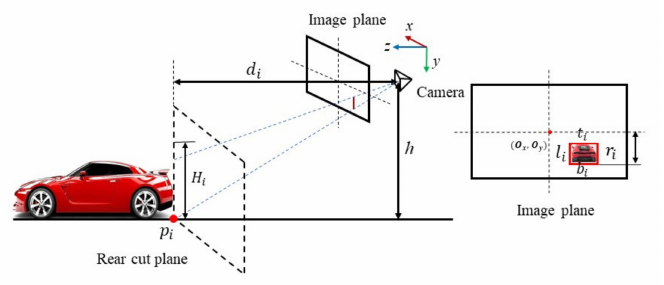
Figure 1. Perspective projection of the vehicle. In the above picture, p is the vehicle’s pickup point, d i denotes the distance to the previous vehicle, h denotes the camera height and l i , t i , r i , b i represent the size of the vehicle frame.